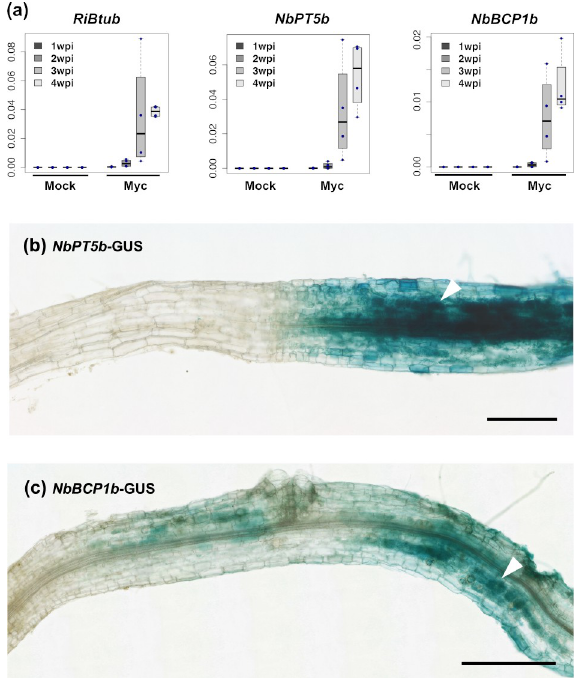
Fig 4. Expression of NbPT5b and NbBCP1b genes is induced under colonisation with Rhizophagus irregularis in Nicotiana benthamiana . (a) qRT-PCR analysis of NbPT5b and NbBCP1b shows that gene expression is induced 2 wpi with R . irregularis and increases with time and degree of colonisation. Y axes indicate expression levels relative to N . benthamiana ’s elongation factor 1 alpha (NbEF). Expression of RiBTub is used as a fungal biomass marker for root colonisation. Raw qRT-PCR values can be found in S3 Data. (b and c) GUS staining of NbPT5b -GUS and NbBCP1b - GUS expressing N . benthamiana roots 4 weeks after inoculation with R . irregularis . GUS activity can only be observed in root areas colonised by R . irregularis and is more predominant in arbuscule-containing cells (white arrows). Scale bar, 500 μ m. qRT-PCR, quantitative real-time polymerase chain reaction; RiBTub, R . irregularis β -tubulin; wpi, weeks